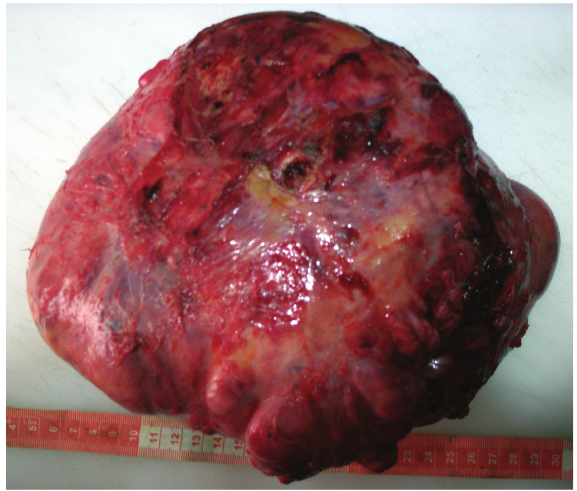
Figure 3: The tumor after